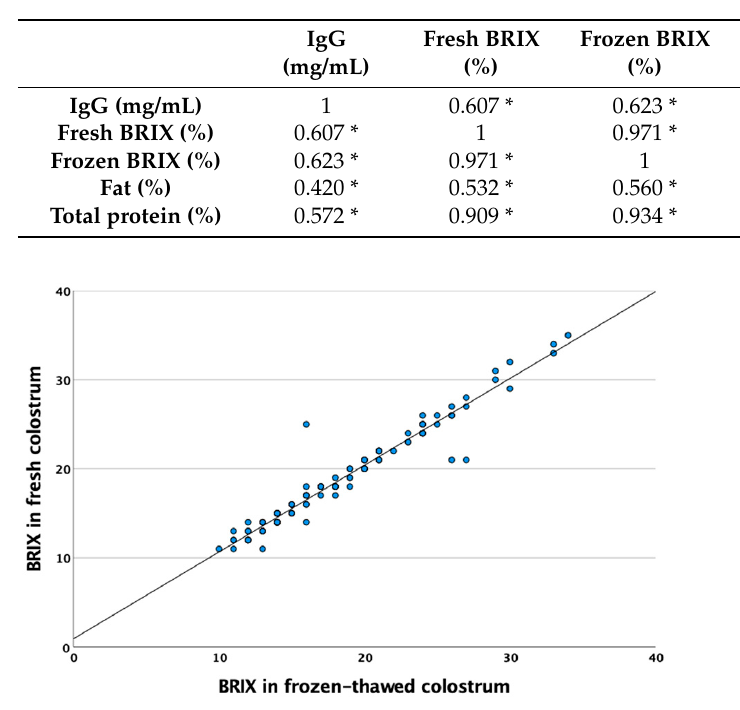
Figure 2. Correlation plots and trend line between fresh and frozen colostrum samples assessed by Brix refractometer.